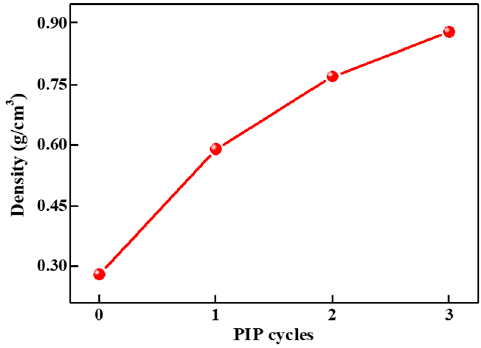
Figure 4. The densities of as-prepared composites with di ff erent pyrolysis process (PIP) cycle numbers.